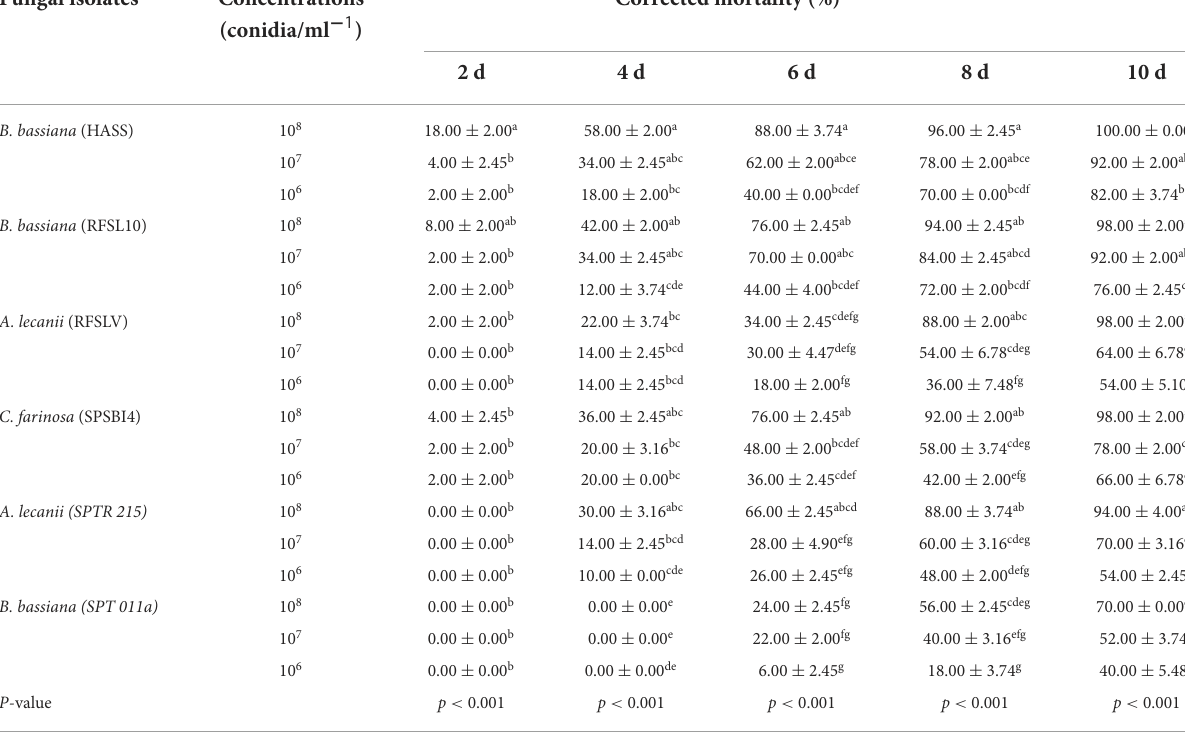
TABLE 2 Mean percentage mortality ± SE of D. opuntiae adult females after exposure to six tested entomopathogenic fungi isolates at 3